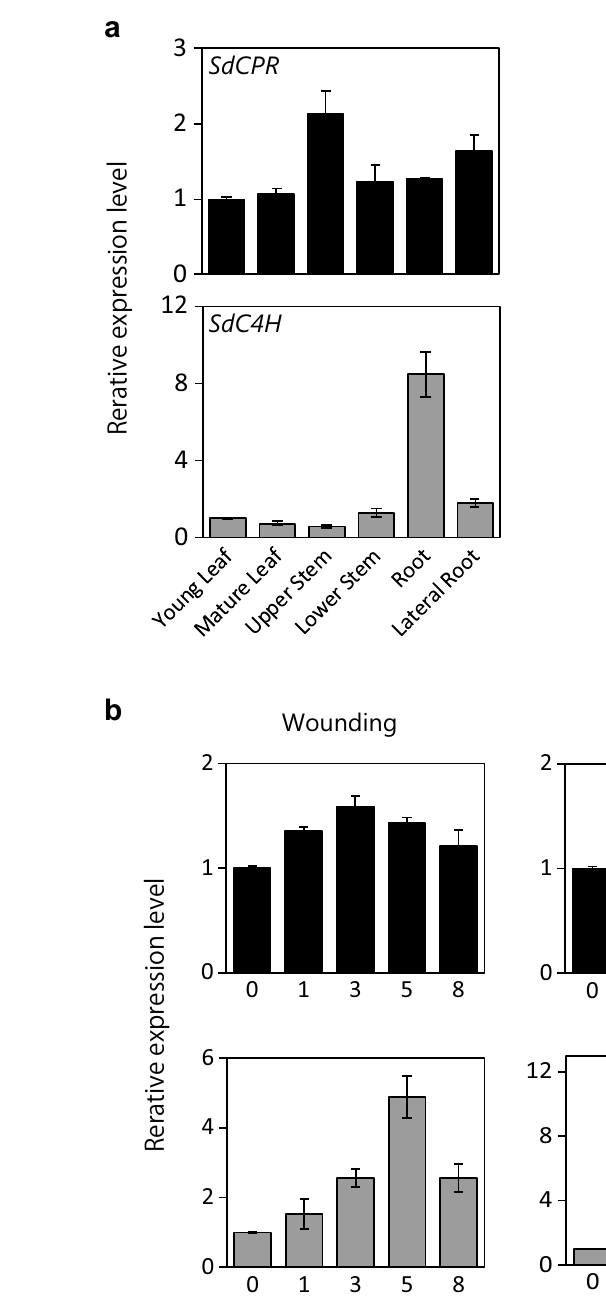
Fig. 4 Real-time qPCR analysis of SdCPR and SdC4H genes. a Tissue-specific accumulation levels of the SdCPR and SdC4H genes in S. dulcis . Each organ was harvested from 8-week-old Scoparia plants for the isolation of total RNA. The transcript levels of each gene in young leaves were set to 1.0. b Effect of various treatments on expression levels of the SdCPR and SdC4H genes. The third leaves of Scoparia plant were treated with wounding, 0.1 mM methyl jasmonate (MJ) and 0.1 mM salicylic acid (SA). The transcript levels of each genes in the leaf at 0 h were set to 1.0. Each data was normalized to an internal control ( GAPDH ), and the ΔΔC T method was used to obtain relative values. Error bars represent the mean (n =